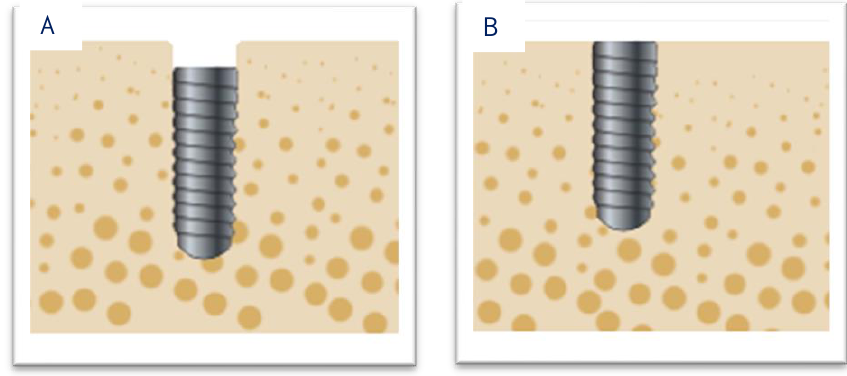
Figure 1. Images of implants placed at the subcrestal ( A ) and crestal ( B ) levels.